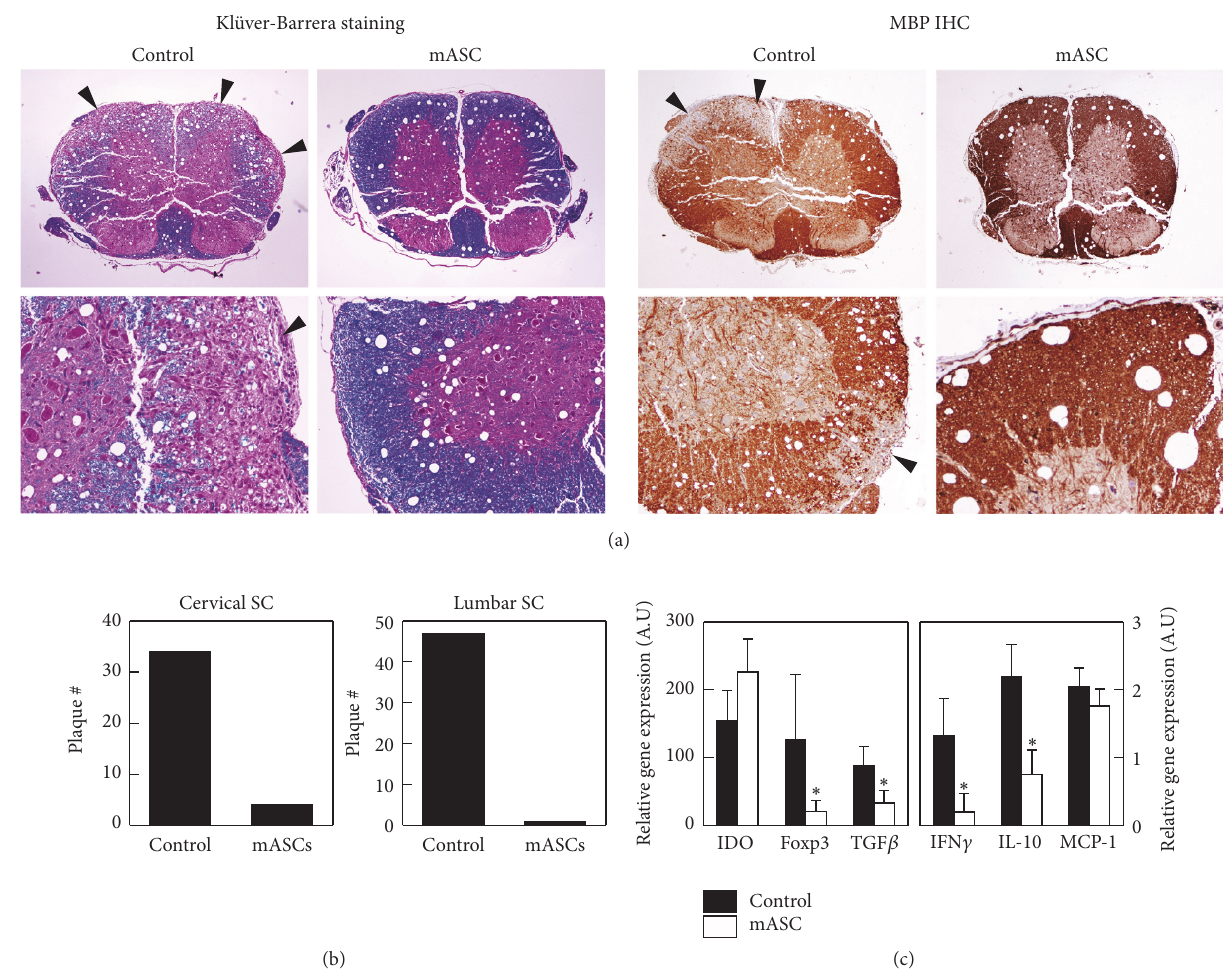
Figure 3: Allogeneic mASCs reduce demyelinization and inflammatory infiltration in the central nervous system during EAE progression. MicewithMOG-inducedEAEwereintraperitoneallyinjectedwithPBS(control, 𝑛 = 4 )orwithmASCsexpandedinhypoxia(10 6 cells/mouse, 𝑛 = 4 ) after the onset of the clinical symptoms, and spinal cords were obtained at the peak of the disease 7 days later. ((a) and (b)) Transverse sections of cervical and lumbar regions of spinal cord were randomly analyzed for the presence of inflammatory infiltrates and plaques of demyelinization using the Kl¨uver-Barrera staining (left panels) and anti-myelin basic protein immunohistochemistry (right panels). Arrows point to areas of demyelinization. (c) Gene expression of different inflammatory markers was determined by PCR in mRNAs isolated from the spinal cords. Results are shown as mean (SD) of 4 mice per group. ∗ 𝑝 < 0.05 versus